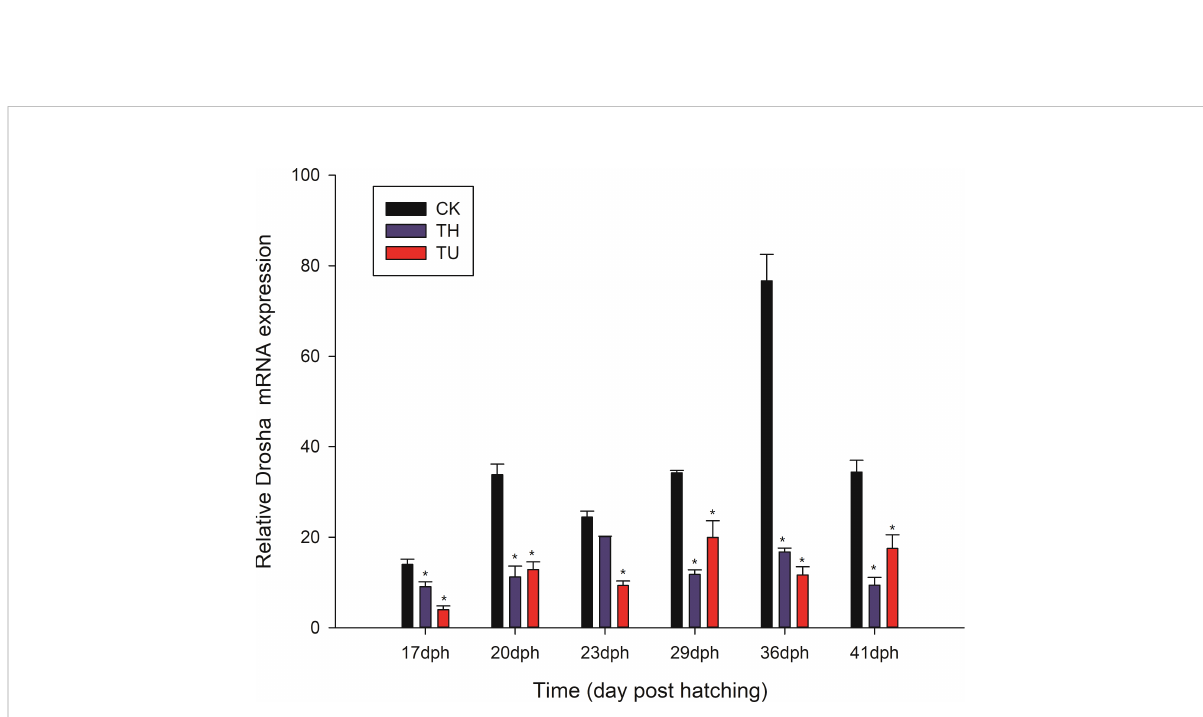
FIGURE 5 Relative Drosha mRNA expression levels in TH- and TU-treated larvae during Japanese fl ounder metamorphosis. Expression values were normalized to those of b -actin, and data are expressed as the means ± Standard Error (SE) (n = 3) from the calibrator group (36 d-TU). CK displayed the untreated group; TH and TU displayed the thyroid hormone and thiourea-treated group. *, indicates a signi fi cant difference (*, p < 0.05)compared to